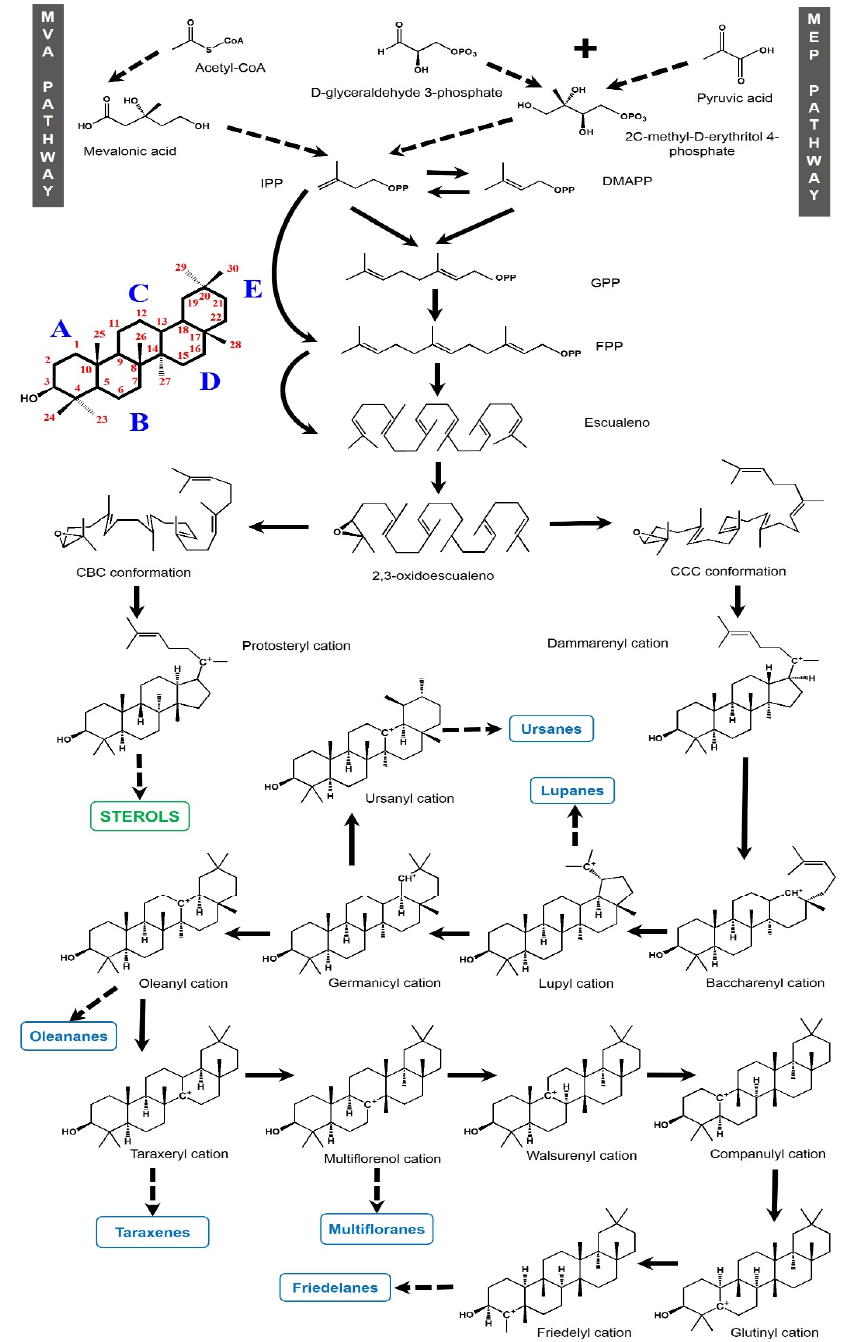
Figure 2. Biosynthetic pathway of PCTs in plants through the mevalonate (MVA) pathway and 2-C-methyl-D-erythritol-phosphate (MEP) pathway, showing the initial substrates, squalene synthesis, and cyclizing and rearrangement of cations that result in the diverse groups of PCTs.